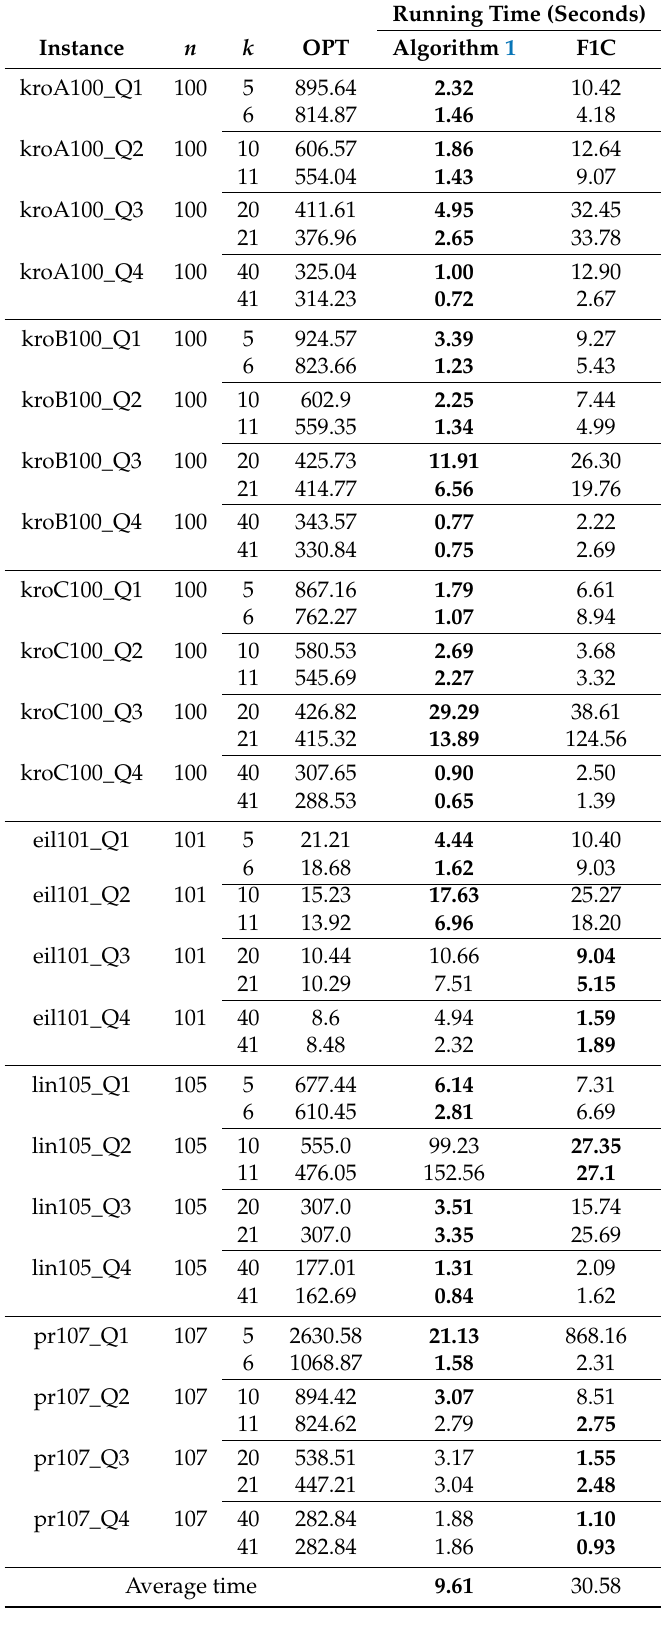
Table 1. Running time and optimal solution size found by Algorithm 1 and the classical formulation F1C over Set 1 using Gurobi 9.0.0. Best running times are in